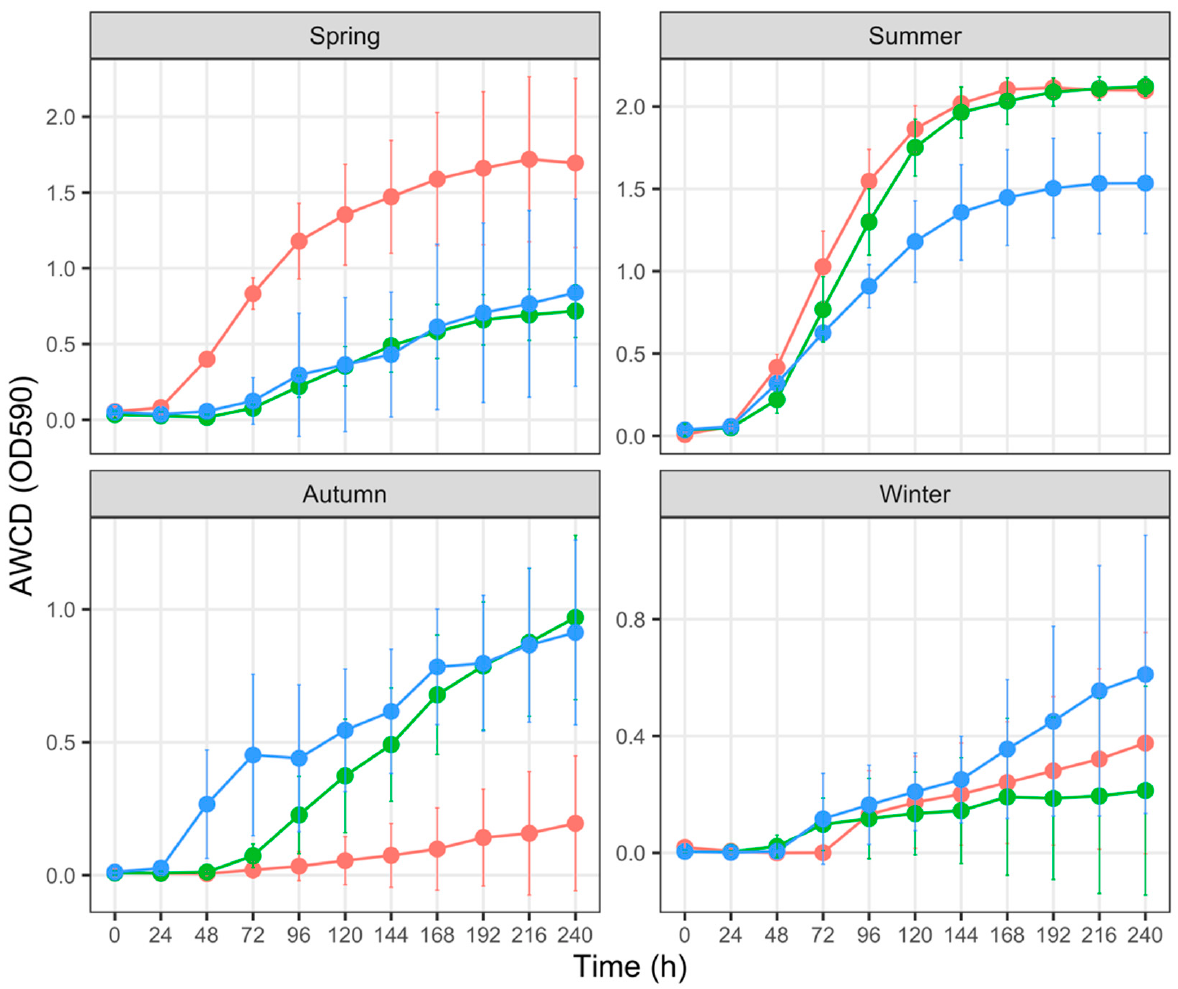
Figure 5. Variation in the average well color development (AWCD) of polymers among three groups of soil samples collected in different seasons. The error bar represents the mean ± SD ( n = 3). AWCD 240 for each soil sample was compared using the Kruskal–Wallis test. Abbreviations: BS—bulk soil; RS—rhizosphere soil; US—uncultivated